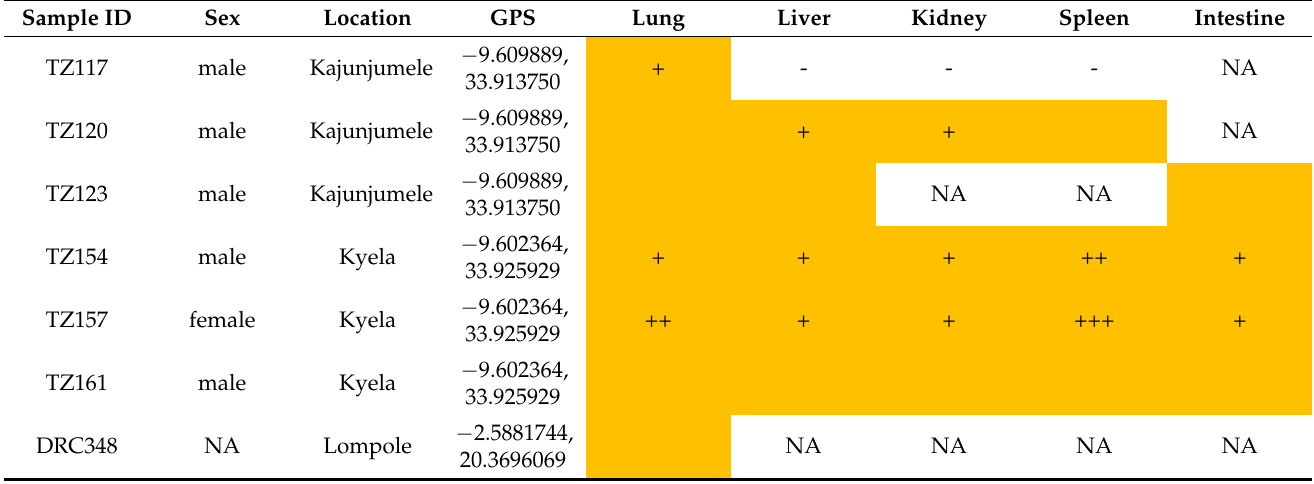
Table 1. Summary of hantavirus test results 1 of samples from Tanzania and DRC.